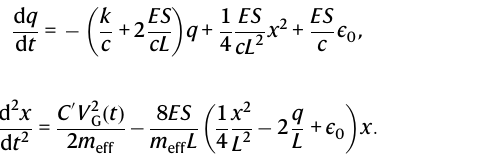
Fig. 4 | Mechanical model reproducing frequency loops. a We assume that the supportedmembraneslidesoverthesubstratecontrollably(doubleheadedarrows in the inset) as a varying electrostatic pressure (vertical arrows) modulates its vertical displacement. b We model this sliding by assuming that the clamping area behaves as a spring and dashpot system. c Schematic of the sliding model. Extending spring feeds extra membrane into the suspended area, making the resonator longer and lowering the resonant frequency f . Contracting spring pulls